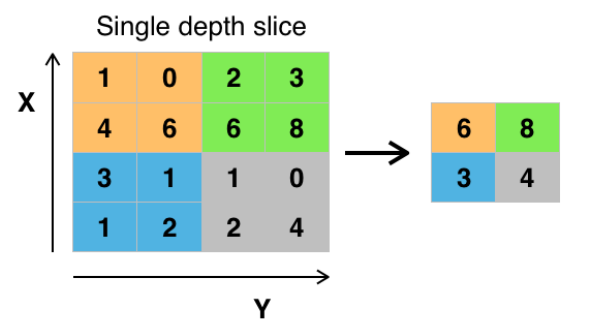
Figure 4. An Example of Max Pooling (image source: [39]). In this example, max pooling is applied for dimensionality reduction via downsampling.The 2 × 2 max pooling window with stride 2 is applied through the data, producing the four